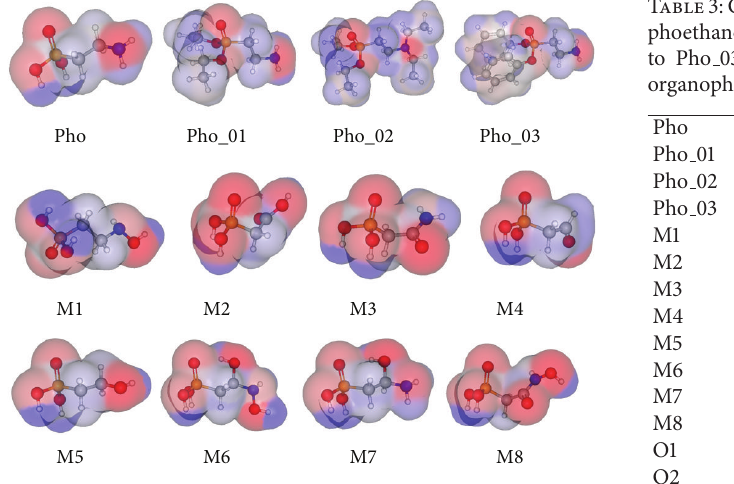
Figure 4: Electrostatics properties of phosphoethanolamine and derivatives. Red color indicates regions with high electronic density.